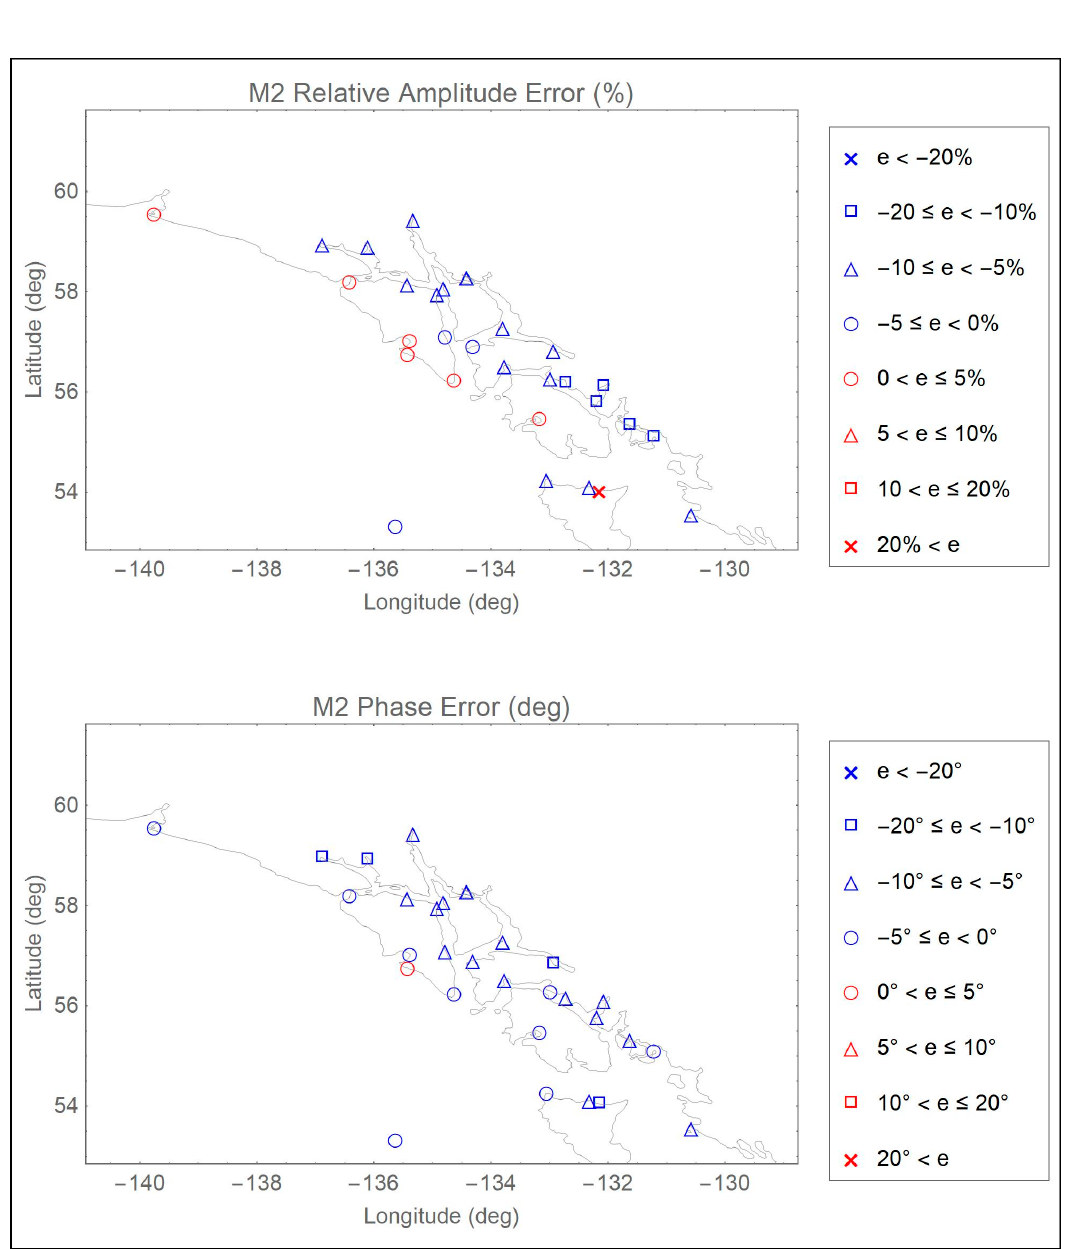
Figure A23. Distribution of ENPAC15 relative amplitude (%) and absolute phase (deg) errors for the M 2 constituent: Southeast Alaska view.